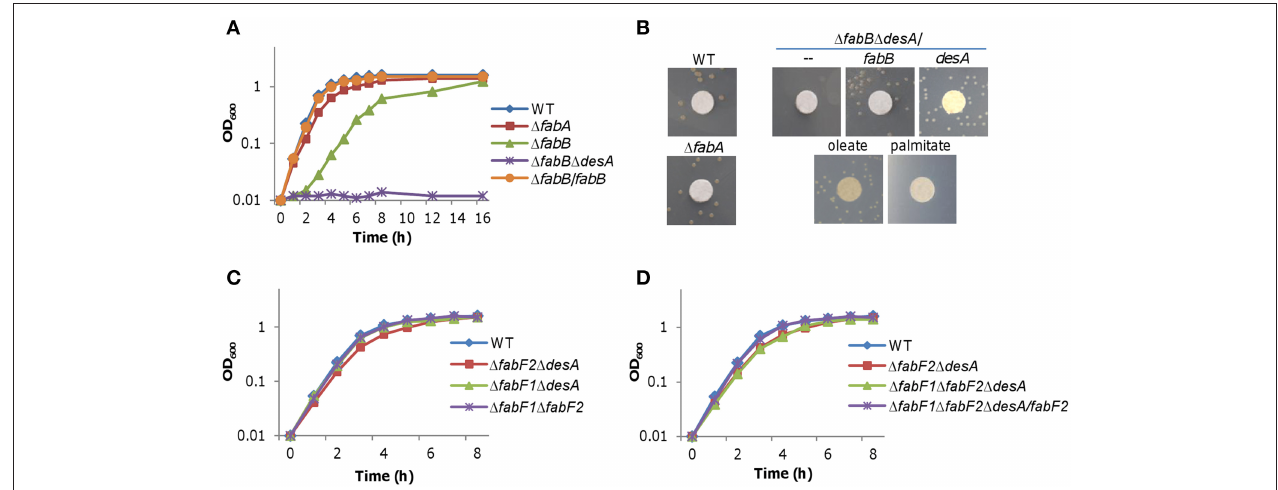
FIGURE 3 | Effects of fabA , fabB , desA , fabF1 , and fabF2 mutations on growth. (A) Growth of 1 fabA and 1 fabB strains in liquid LB. 1 fabB / fabB represents the 1 fabB strain carrying a copy of fabB integrated in the chromosome driven by its native promoter. (B) Growth of 1 fabB and 1 fabB 1 desA strains on solid media under various conditions. Differences in growth were assessed with colony features: presence vs. absence, and size. A paper disc of 5mm in diameter was placed on the plate for size assessment. Cultures of the mid-log phase for each strain were properly diluted, placed on LB plates, incubated for 24h (for size comparison) and 48h (for presence vs. absence) under aerobic conditions. Complementation either chemically (0.005% oleate or palmitate) or genetically (expression of fabB or desA in trans ) was performed. Results shown are representative of three independent experiments. (C,D) Growth of 1 fabF1 1 desA and 1 fabF2 1 desA strains in liquid LB. Single mutant strains 1 fabF1 and 1 fabF2 were indistinguishable from the wild-type under experimental conditions (not shown). 1 fabF1 1 fabF2 1 desA / fabF2 represents the triple mutant carrying a copy of fabF2 integrated in the chromosome driven by its native promoter. In (A–C) , error bars (less than 10% of the average), representing SD from three independent experiments, were omitted for clarity.